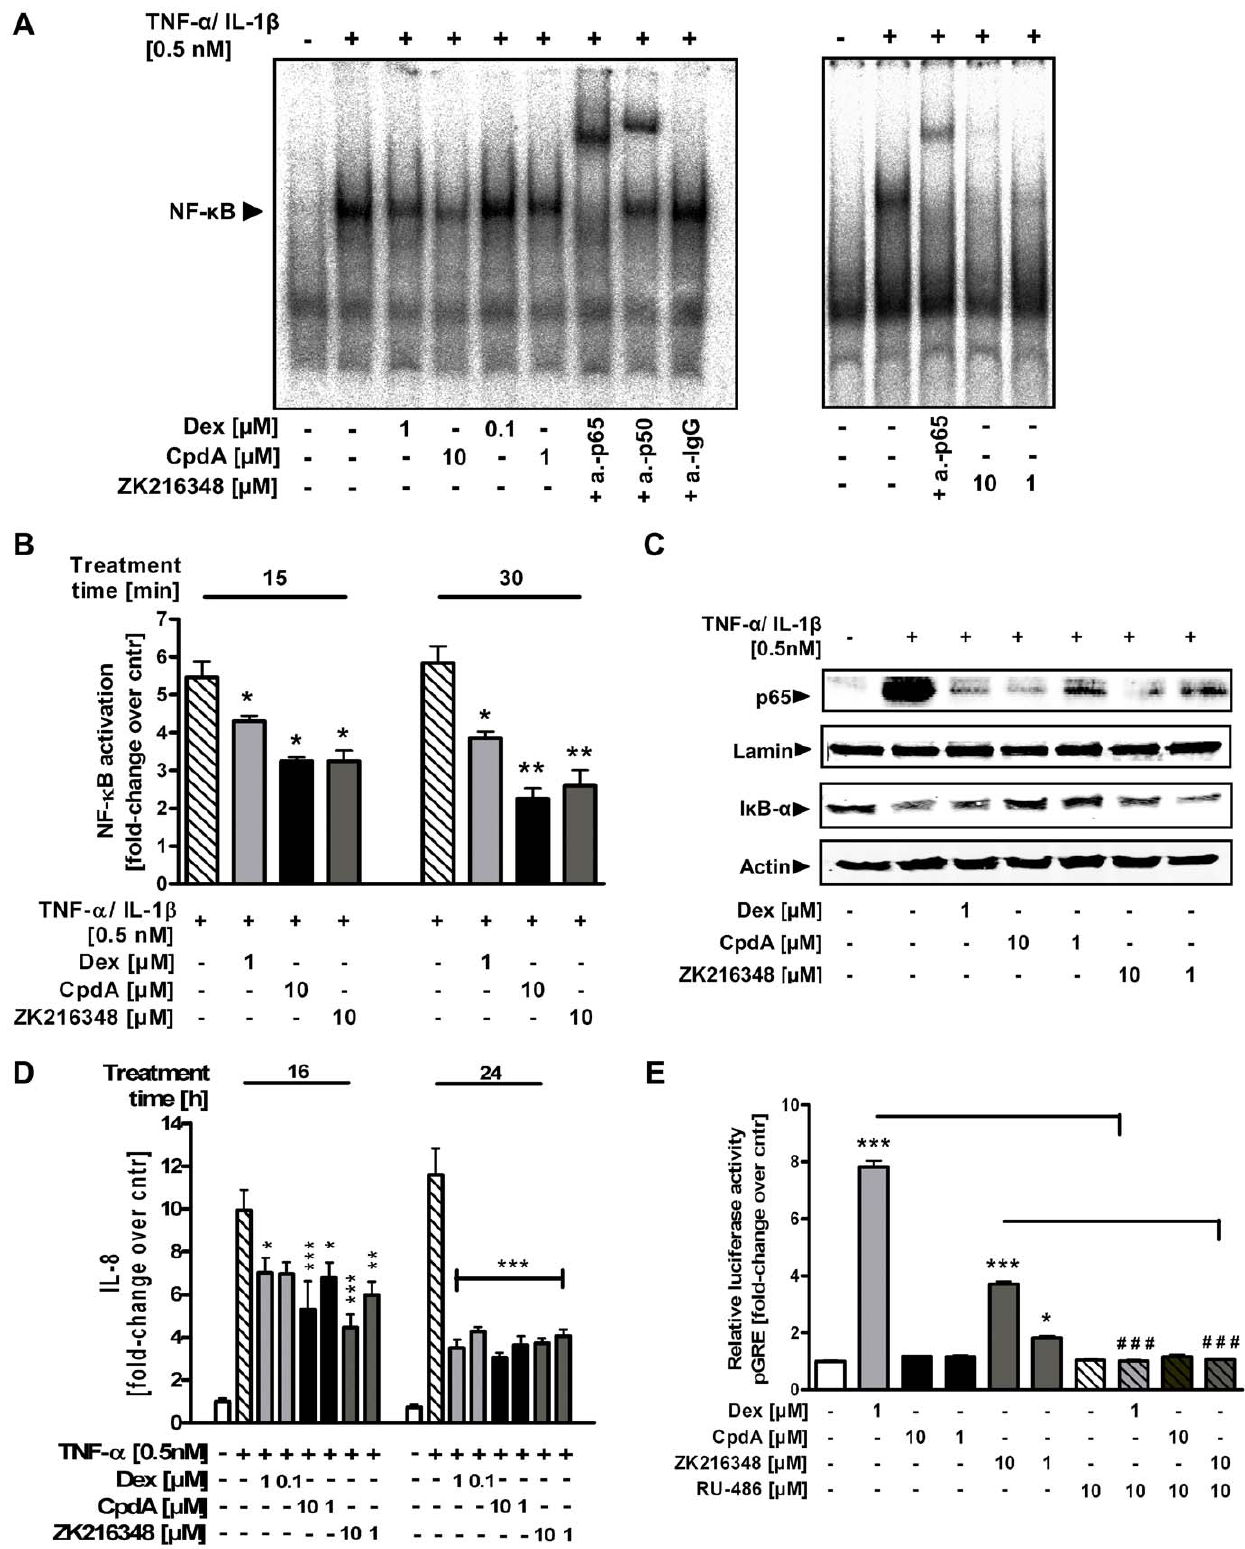
Figure 2. Effect of SEGRAs on transcriptional activity of GR. Cells were pre-treated with Dex [0.1–1 m M], CpdA or ZK216348 [1–10 m M] for 1 h before cultivation in the co-presence or absence of TNF- a /IL-1 b [0.5 nM] and harvested for cytoplasmic and nuclear protein extract preparations. ( A ) The activity of NF- k B in nuclear extracts of IEC-6 cells was analysed by EMSA using an end-labelled NF- k B consensus oligonucleotide. The EMSA is representative for two experiments giving similar results. ( B ) NF- k B activity in nuclear extracts of Caco-2 cells was measured by transcription factor assay for p65. ( C ) Western blot analysis for nuclear p65, or cytoplasmic I k -B a expression in TNF- a -/IL-1 b -stimulated Caco-2 cell extracts. One